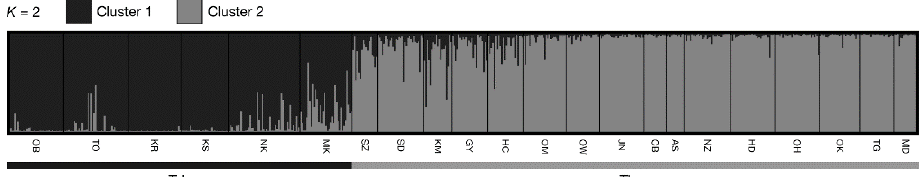
Figure 3. The proportions of cluster memberships at the individual level in the 22 genus Thujopsis populations based on STRUCTURE software analysis. Populations are represented from the left (southern populations) to the right (northern populations). Table 3. Hierarchical analysis of genetic structure using analysis of molecular variance (AMOVA) and hierarchical F statistics.